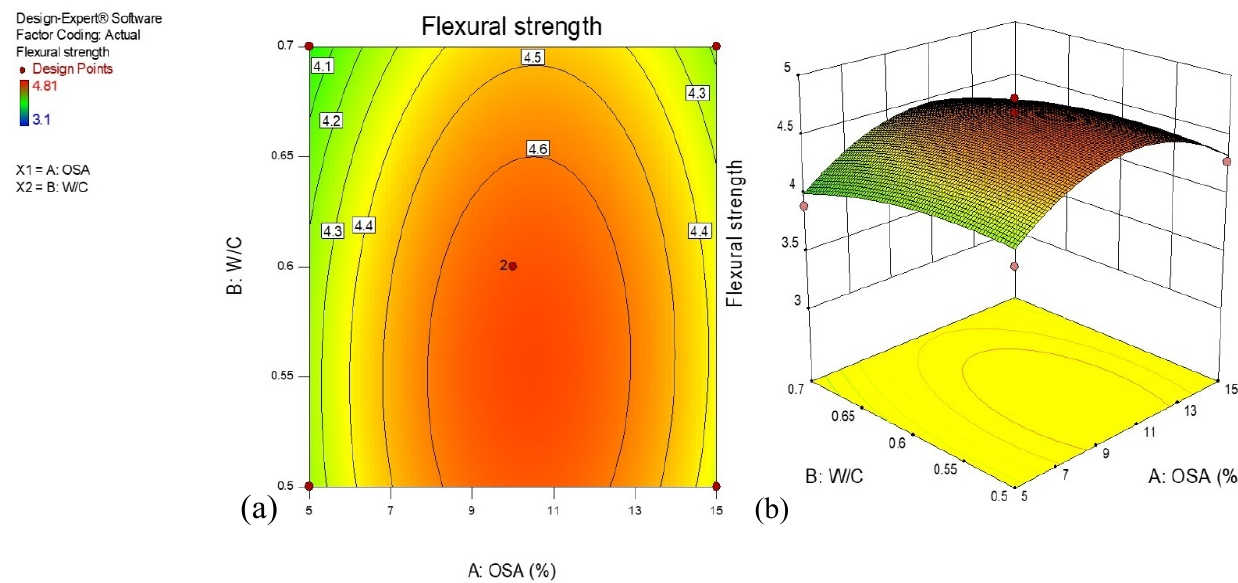
Figure 7. ( a ) 2-D and ( b ) 3-D plots for flexural strength of cement-based mortar.